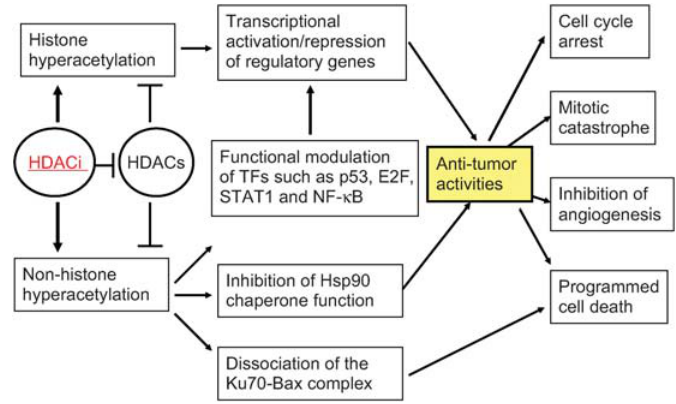
Figure 1 Molecular mechanisms of anticancer activities by HDACi. HDACi induce histone hyperacetylation, which in turn modulates gene activity at the transcriptional level. Alternatively, HDACi modulate non-histone protein hyperacetylation that leads to functional modulation of a number of TFs that also regulate transcription of other genes. The other major effects are the inhibition of hsp90 chaperone function and dissociation of the Ku70-Bax complex. All these events lead to antitumoral effects including cell cycle arrest, mitotic catastrophe, programmed cell death and inhibition of